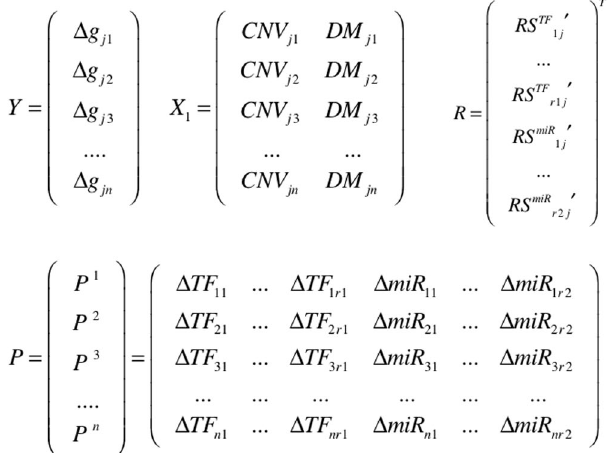
Figure 9. Four matrices constructed for each gene j and each condition, i.e., a specific cancer stage. Y represents the vector of expression changes of gene j in the corresponding cancer patients under this condition; X 1 represents the matrix of background adjustment factors (CNV and DNA methylation); R represents a RS vector that contains the regulatory scores of all r 1 TF- and r 2 miRNA- regulators of gene j ; P is the matrix that includes all the expression changes of each regulator in each patient under the corresponding